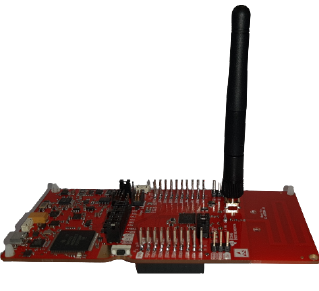
Figure 3. Target node